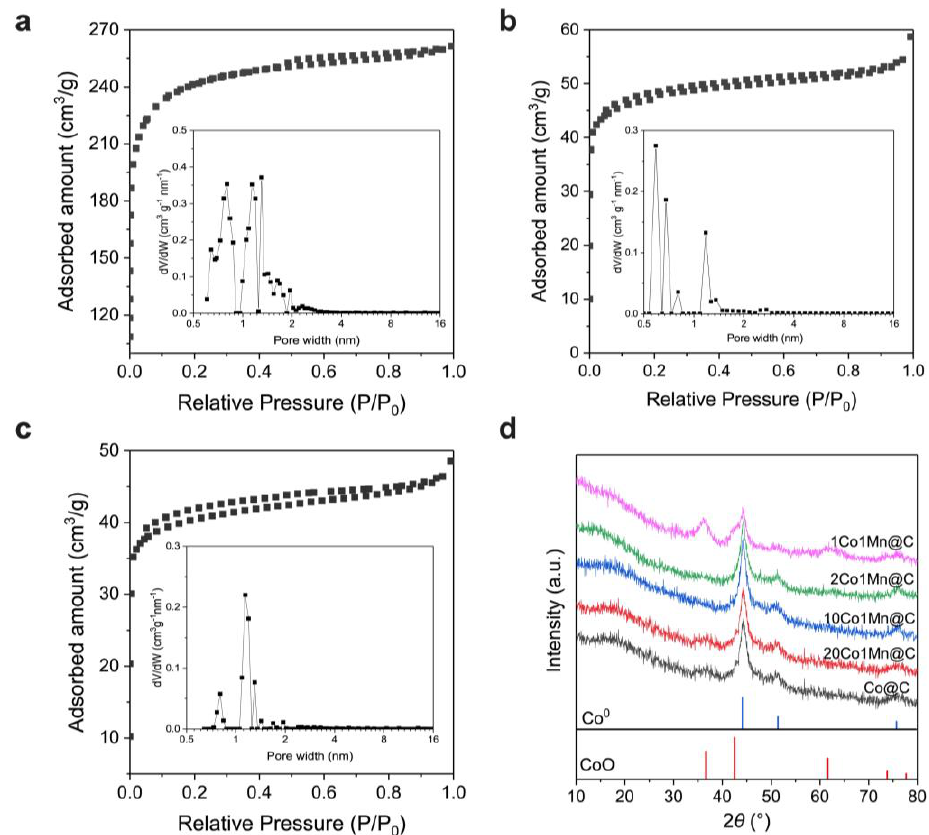
Figure 3. N 2 adsorption–desorption isotherms and pore size distribution: ( a ) Co@C, ( b ) 10Co1Mn@C, ( c ) 2Co1Mn@C. ( d ) XRD patterns for MOF-derived CoMn@C composites.